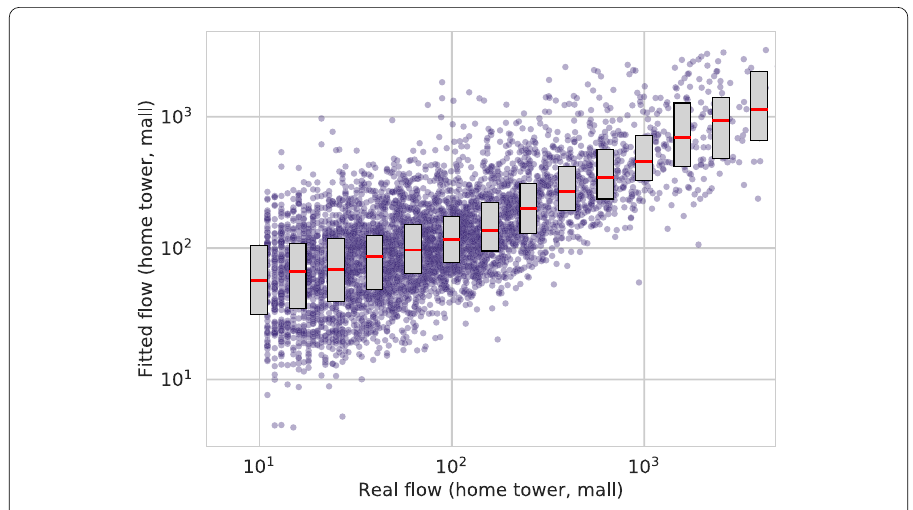
Figure 8 Scatter plot and boxplots representing the real flows from each home location towards each mall on the x -axis, and the fitted flows on the y -axis, for the modulated-distance gravity model. For the boxplot 15 bins were constructed, equally spaced on the log-scale, and each box shows the median (red bar) and the first and third quantiles (bottom and top lines) of the fitted